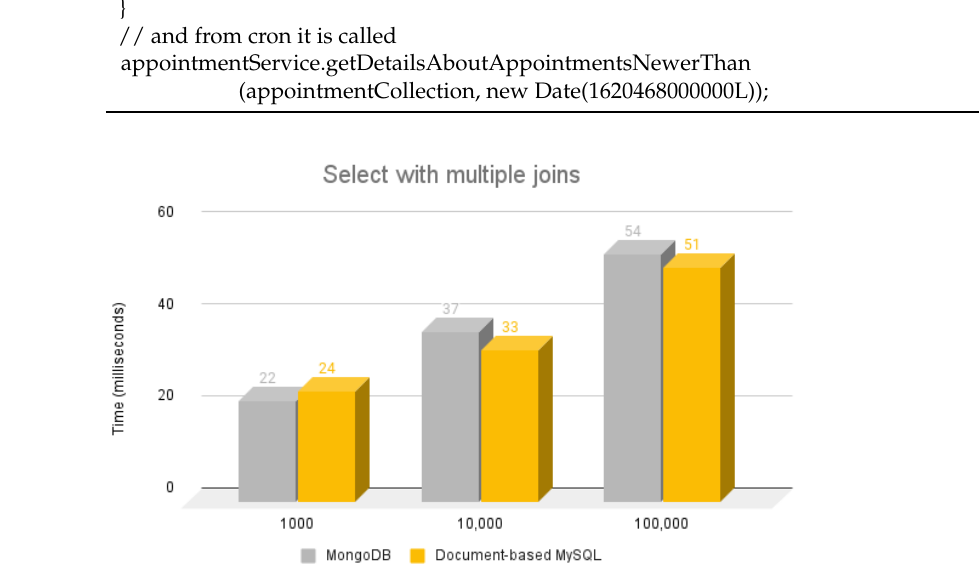
Figure 8. Execution times for select with multiple